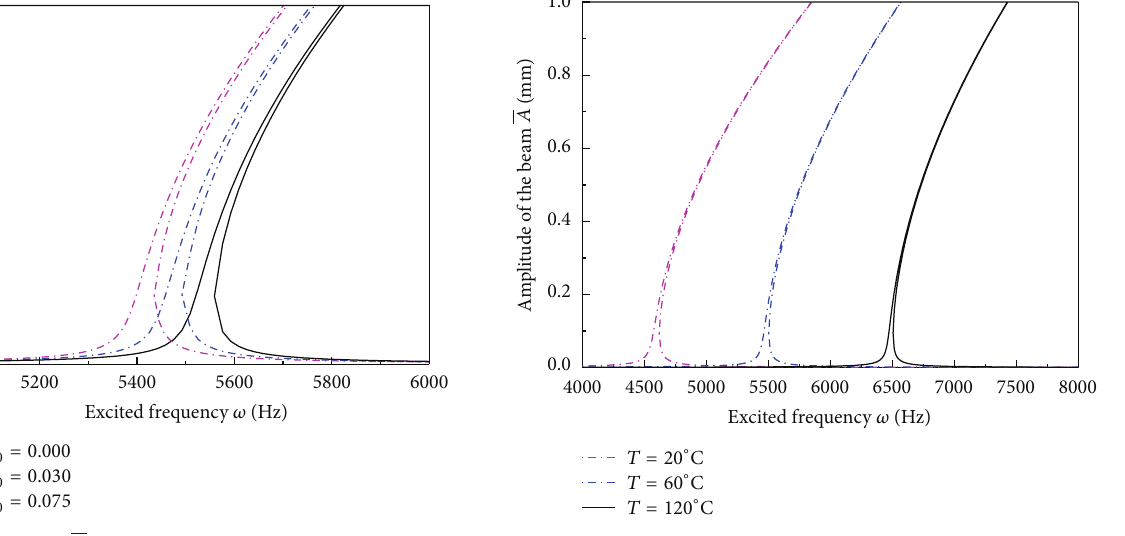
Figure 18: Amplitude 𝐴 versus frequency responses of the com- posite beams in the phase transformation state from Martensite to Austenite under the excitations for different 𝑇 ( 𝜀 0 = 0.036 , 𝑉 𝑠 = = 10 N, 𝐿/ℎ = 10 0.005 , 𝑞 0